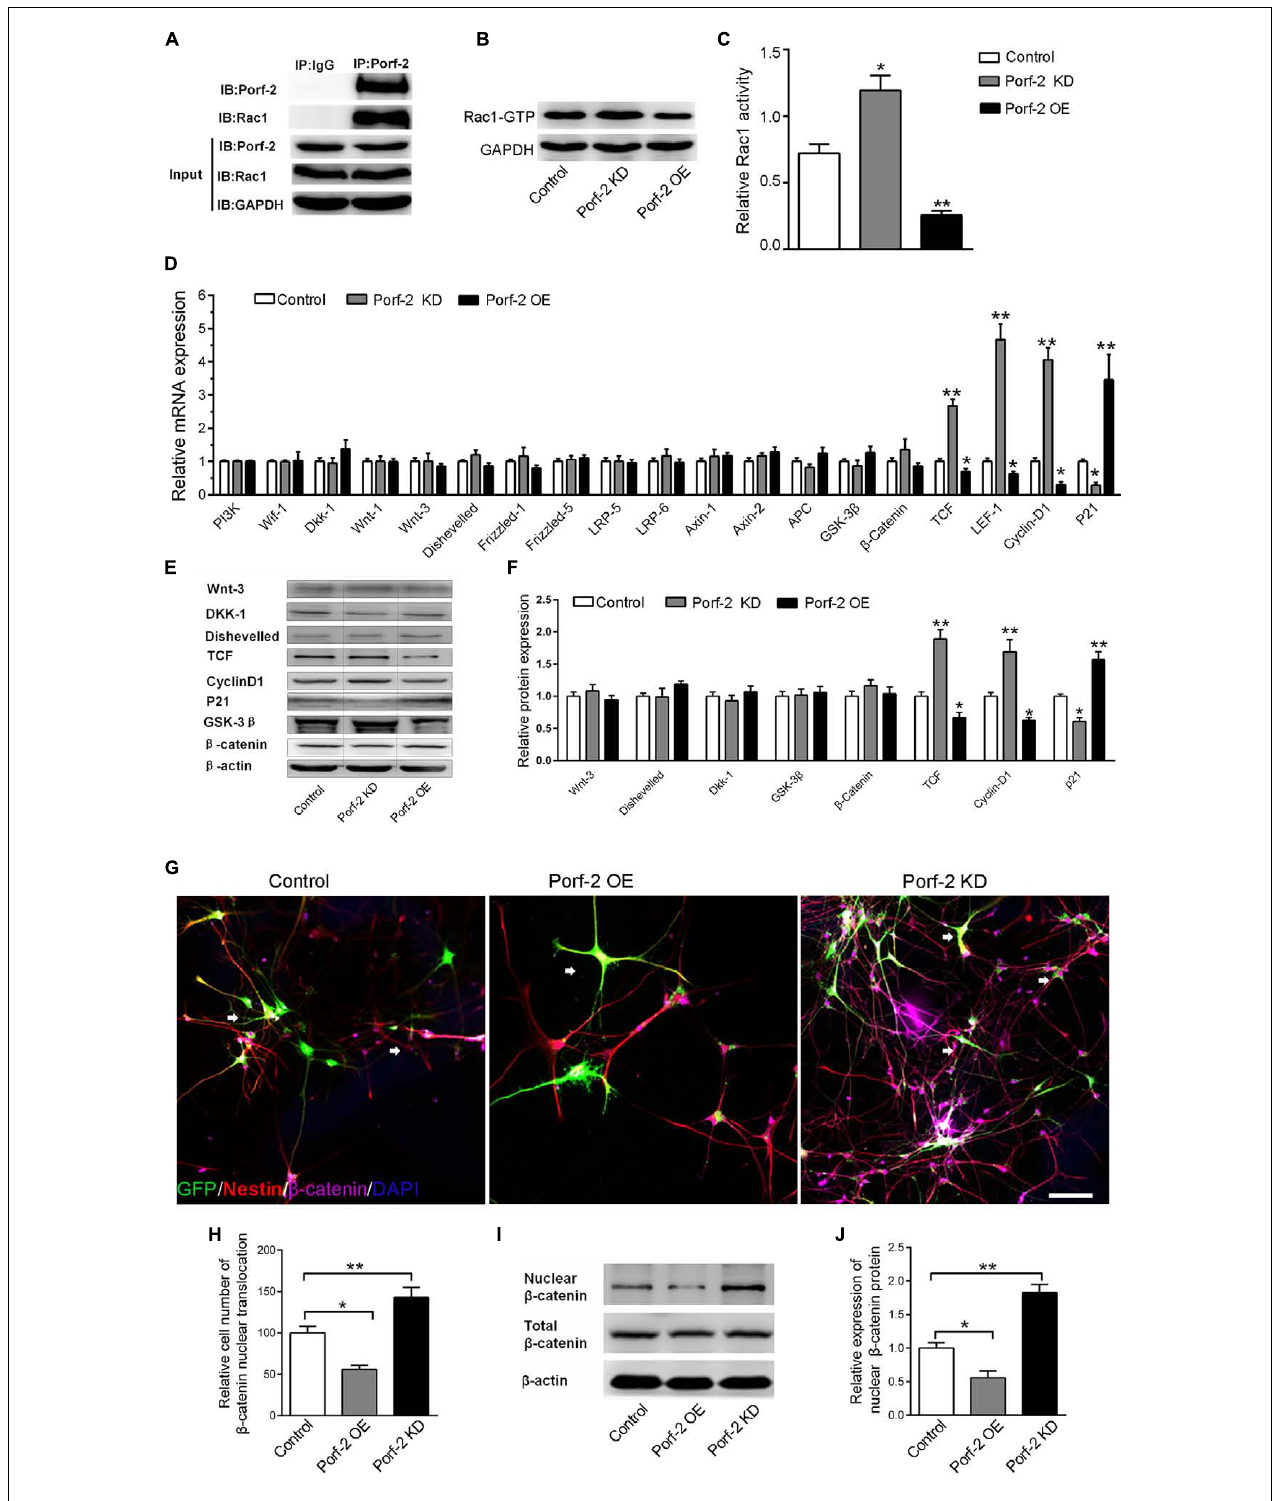
FIGURE 3 | Effect of Porf-2 downregulation or overexpression on Rac1 activity and Wnt/ β -catenin signaling pathway in NSCs. (A) Co-immunoprecipitation experiments showed that Porf-2 and Rac1 co-immunoprecipitated. (B,C) Cell lysates were processed to analyze Rac1 activation by pull-down. Effect of Porf-2 knockdown or overexpression on Rac1 activation. NSCs were transfected with knockdown, overexpression, or control vector. GAPDH was used as a housekeeping gene for normalization. (D) RT-PCR analysis was performed to determine the relative mRNA expression of Wnt/ β -catenin pathway genes in the three groups.